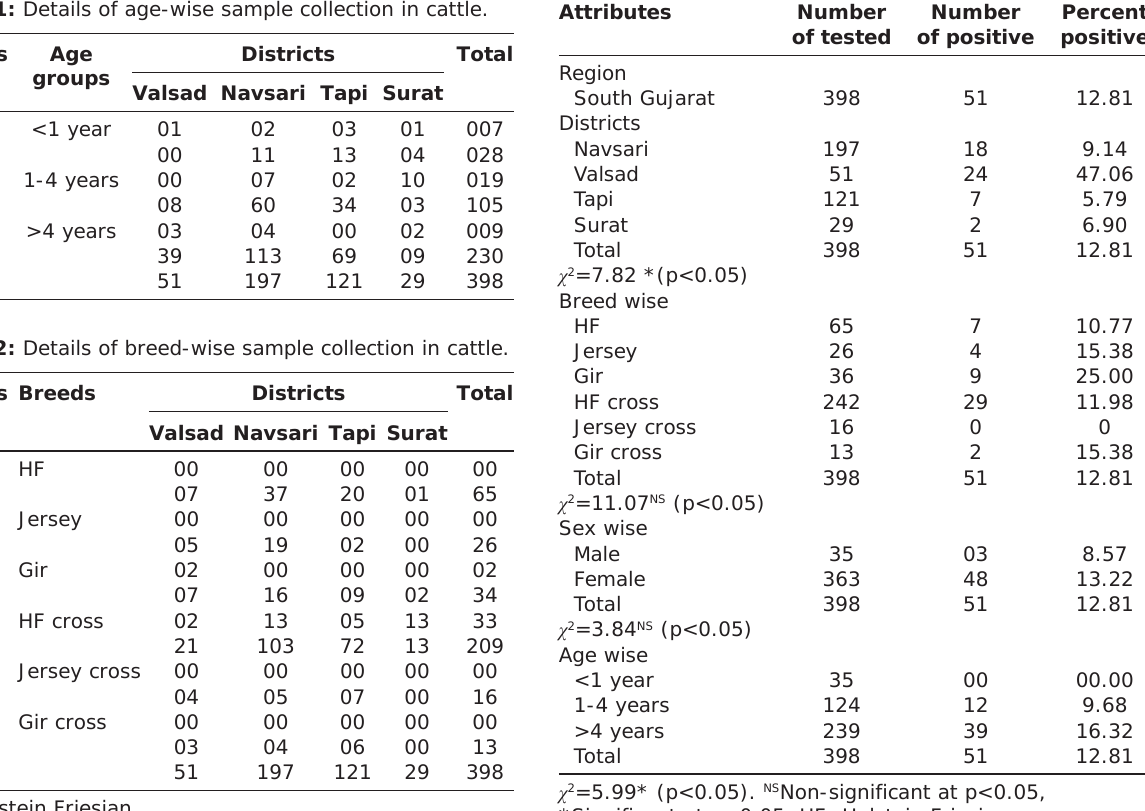
Table-4: Seroprevalence of leptospirosis in